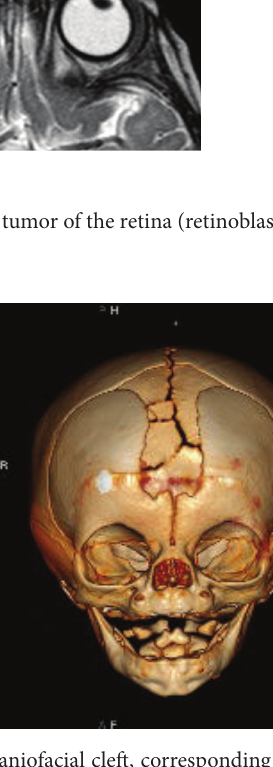
Figure 3: Craniofacial cleft, corresponding to a Tessier 14 midline craniofacial cleft, between nose and facial